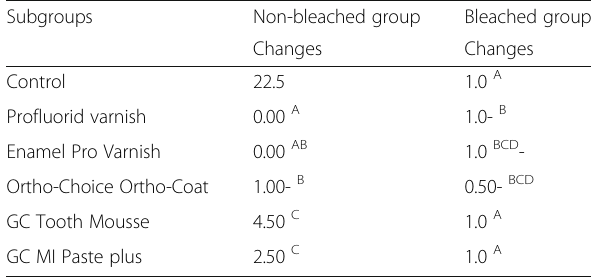
Table 2 Medians of DIAGNOdent values of demineralization changes for different bleached and non-bleached subgroups